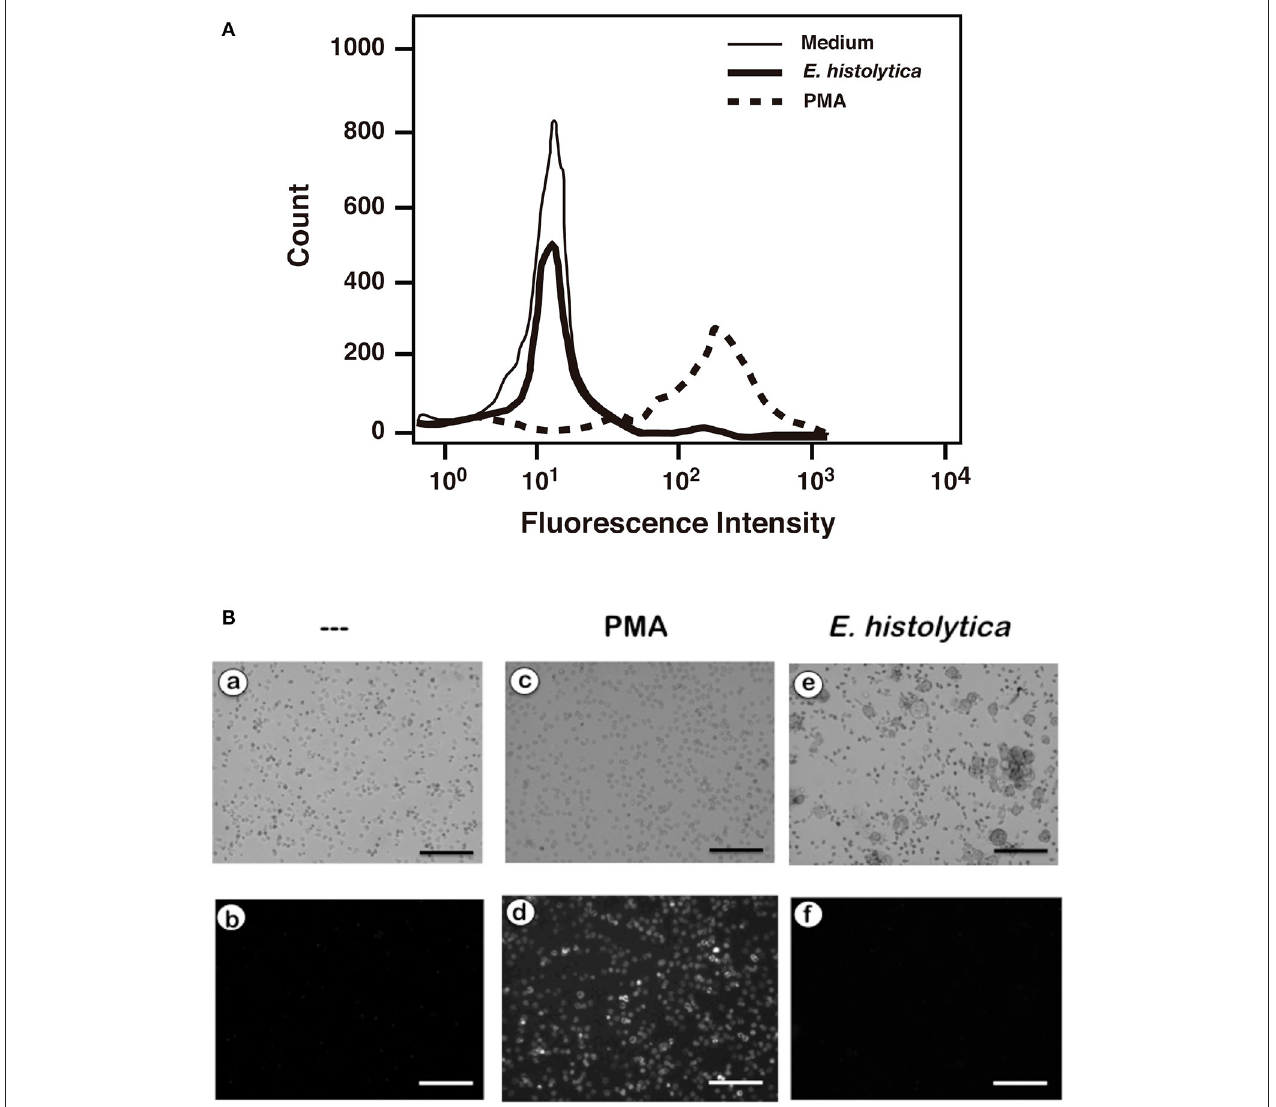
FIGURE 10 | Entamoeba histolytica does not induce Reactive Oxygen Species (ROS) formation. Human neutrophils were previously incubated with the ROS-sensitive fluorescent compounds (A) dihydrorhodamine 123 (15 µ M), or (B) dihydroethidium (15 µ M). Next, neutrophils were not stimulated (—), or were stimulated with 20nM phorbol 12-myristate 13-acetate (PMA), or with E. histolytica trophozoites. After 1h, cells were analyzed by flow cytometry (A) or by fluorescence microscopy (B) . Data are representative of three independent experiments. Bar is 100 µ